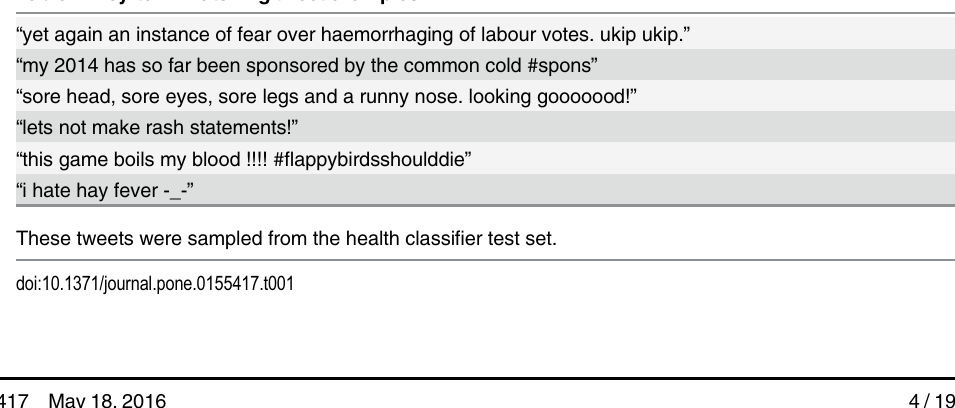
Table 1. Key-term matching tweet